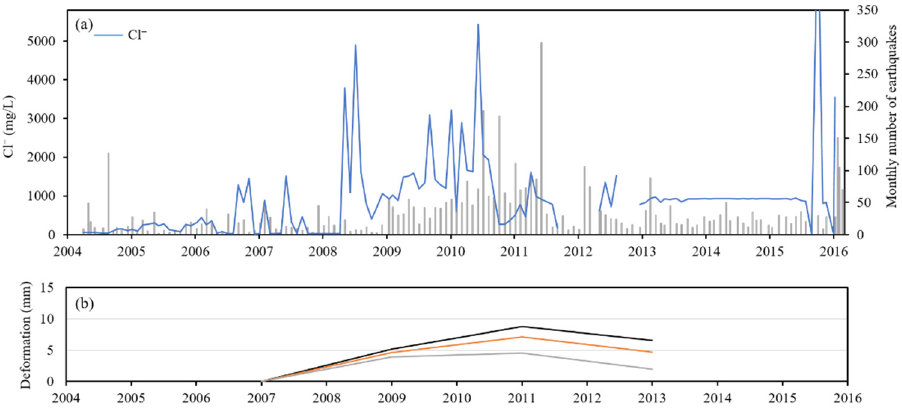
Figure 6. Correlation between the Cl − concentration of TYK waters and ( a ) monthly number of earth- quakes. ( b ) Vertical deformations of benchmarks in TYK area according to [16].